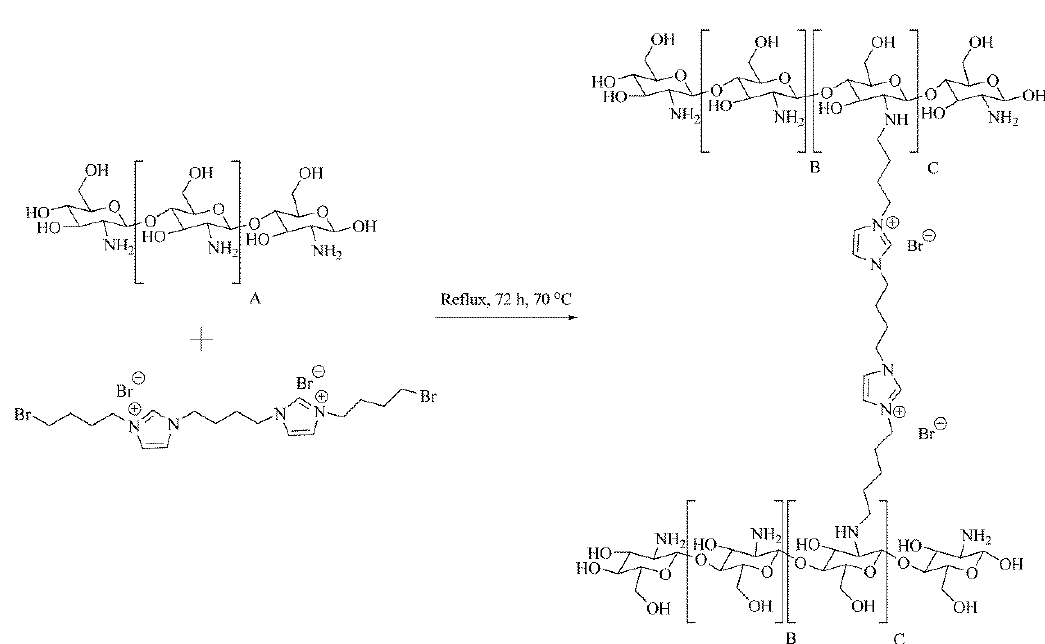
Scheme 16. Synthetic procedure for preparation of the Ch-ILBr catalyst.